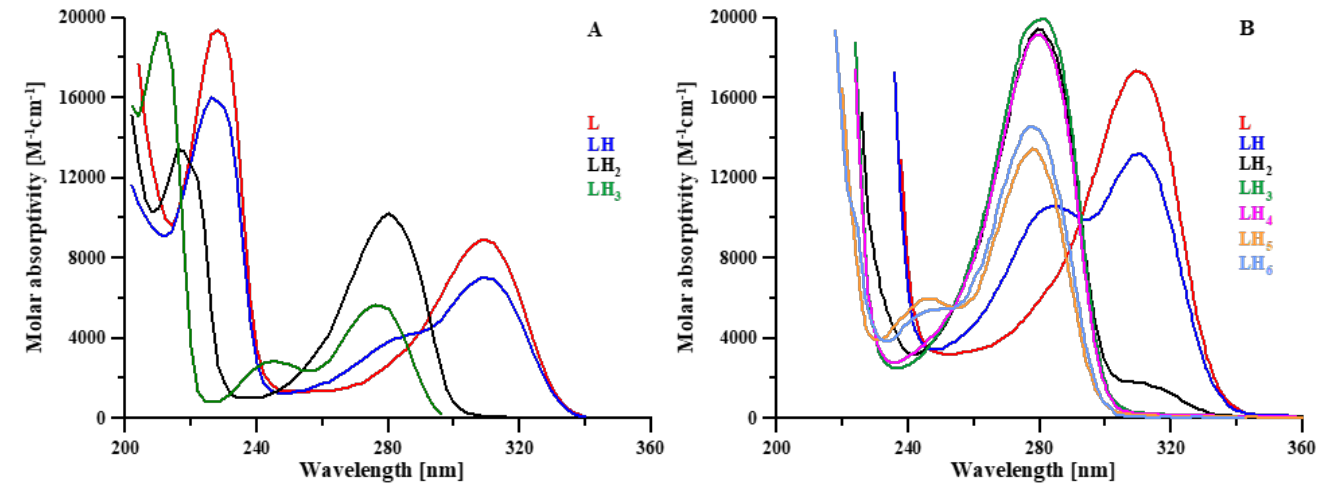
Figure 3. Calculated molar absorptivity spectra of the differently protonated forms of L5 ( A ) and KC21 ( B ) ligands.